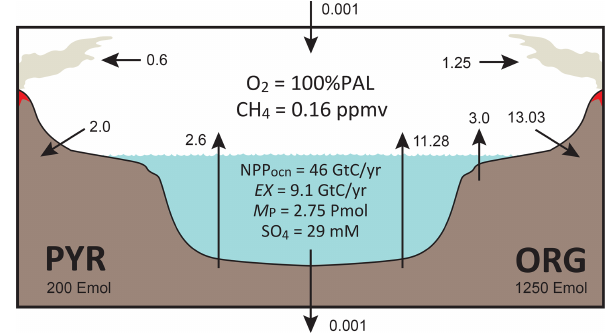
Figure 17. Schematics of global redox (O 2 ) budget for the reference run. Arrows represent the O 2 flux in terms of 10 12 molO 2 equiv.yr − 1 . PAL stands for present atmospheric level. Pmol is 10 15 mol. Emol is 10 18 mol. ORG represents sedimentary organic carbon. PYR represents sedimentary pyrite sulfur. NPP ocn is oceanic net primary production. EX stands for export production. MP is oceanic phosphate inventory. SO 4 represents the concentra- tion of